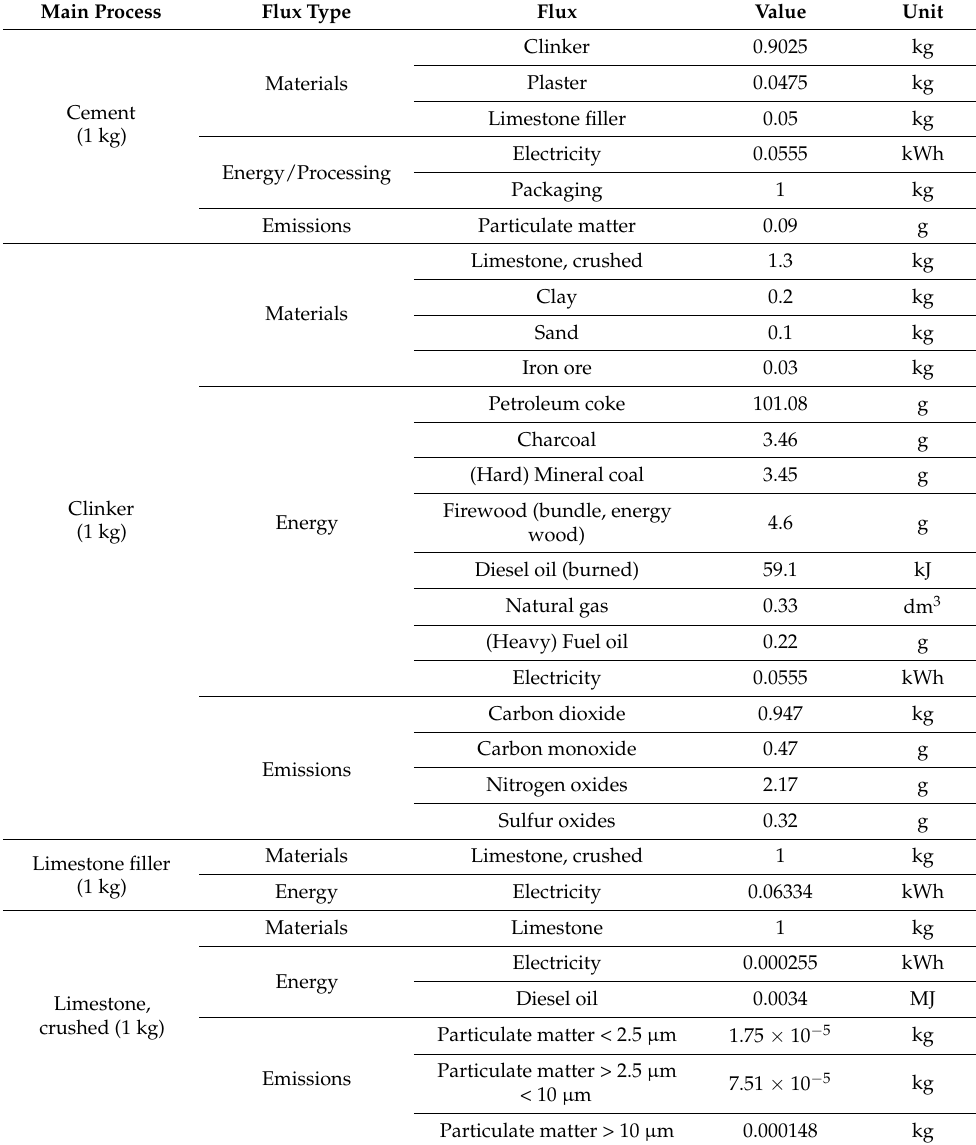
Table 5. Materials and cement Life Cycle